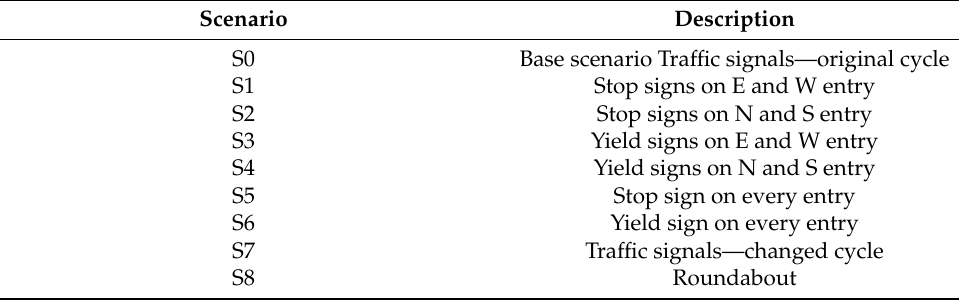
Table 3. Modeled scenarios regarding traffic organization and intersection types.